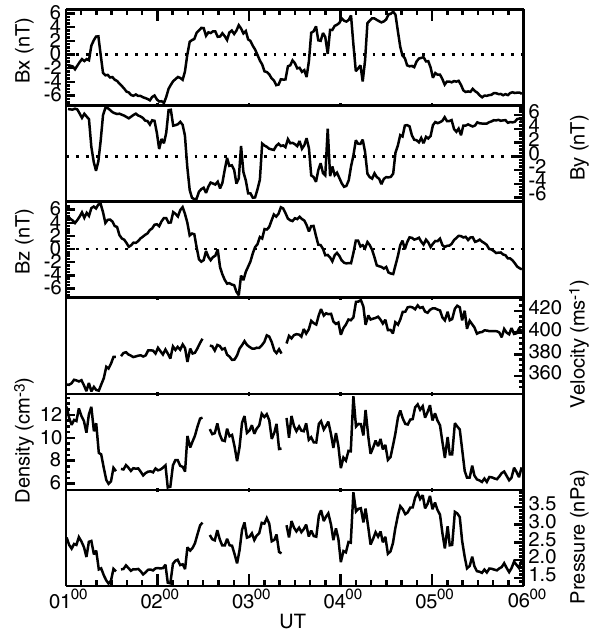
Fig. 2. Solar wind and IMF data from the WIND SWE and MFI instruments on 20 December 1998. The times shown are at the spacecraft, a time delay of ∼ 10min to the ionosphere has been calculated. The top three panels display components of the inter- planetary magnetic field in GSM coordinates. The bottom three panels indicate solar wind bulk velocity, density and pressure, re- spectively. WIND was located at approximately (40 R E , 60 R E , 10 R E ), ( X,Y,Z ) in GSM coordinates during this